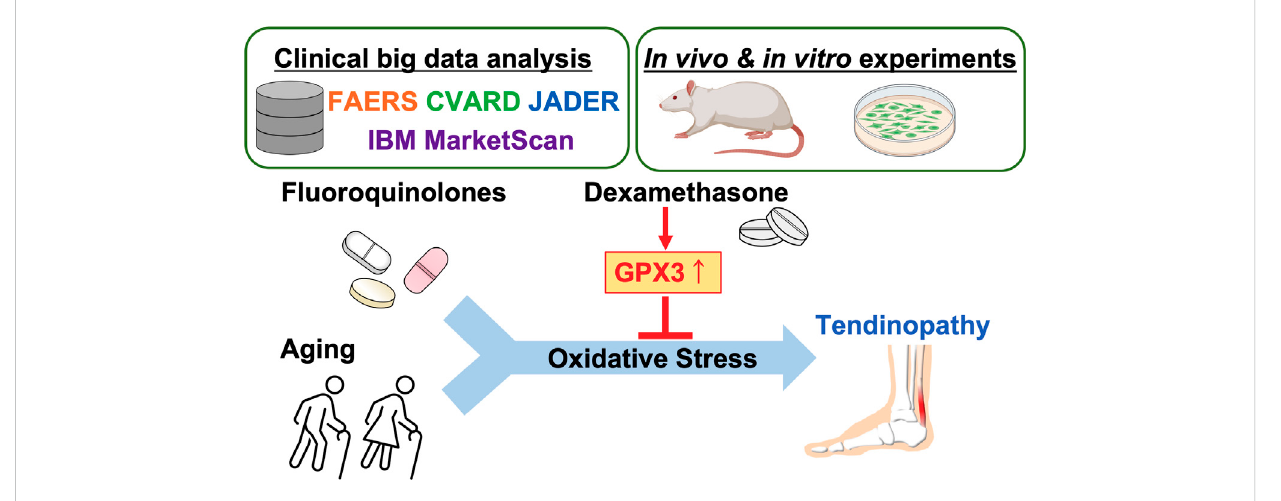
FIGURE 8 Graphical summary of the study. Created with